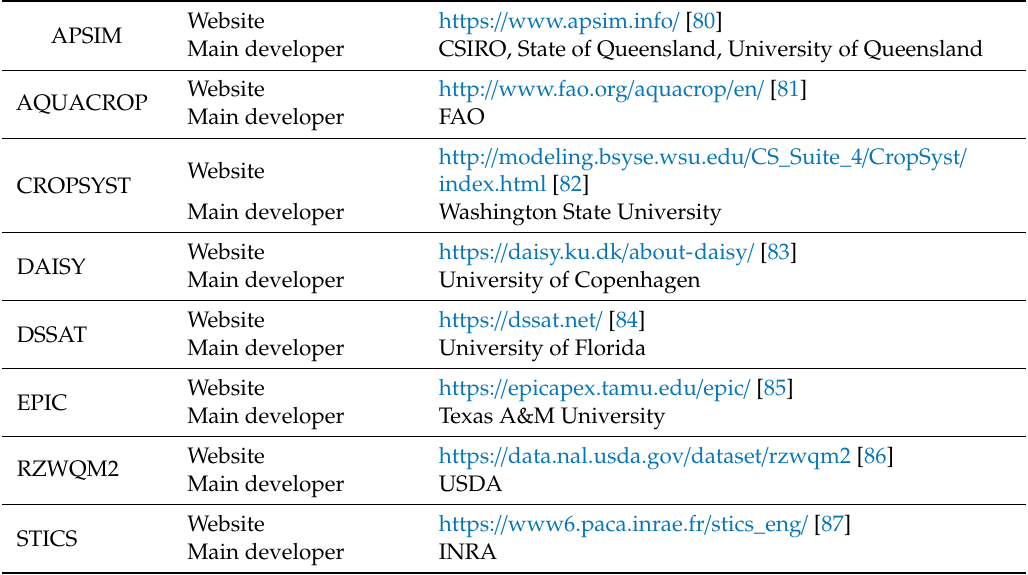
Table 1. Selected models, website to download software and documentations and core institutions developing and maintaining